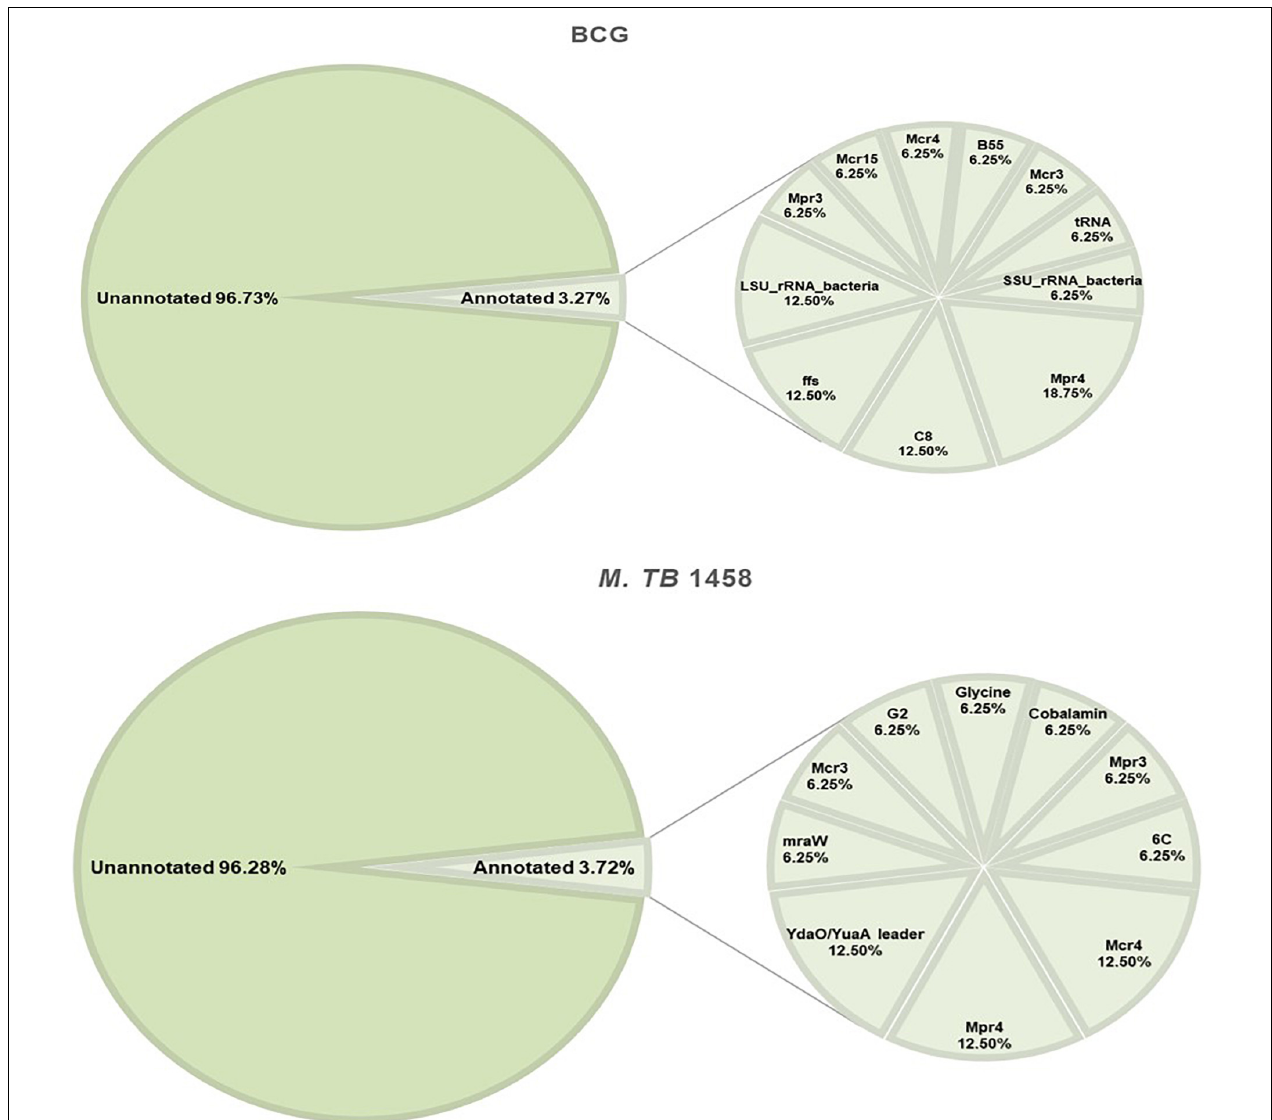
FIGURE 5 | Annotation results of BCG and Mycobacterium tuberculosis 1458 ncRNAs by Rfam and BRSD sRNA